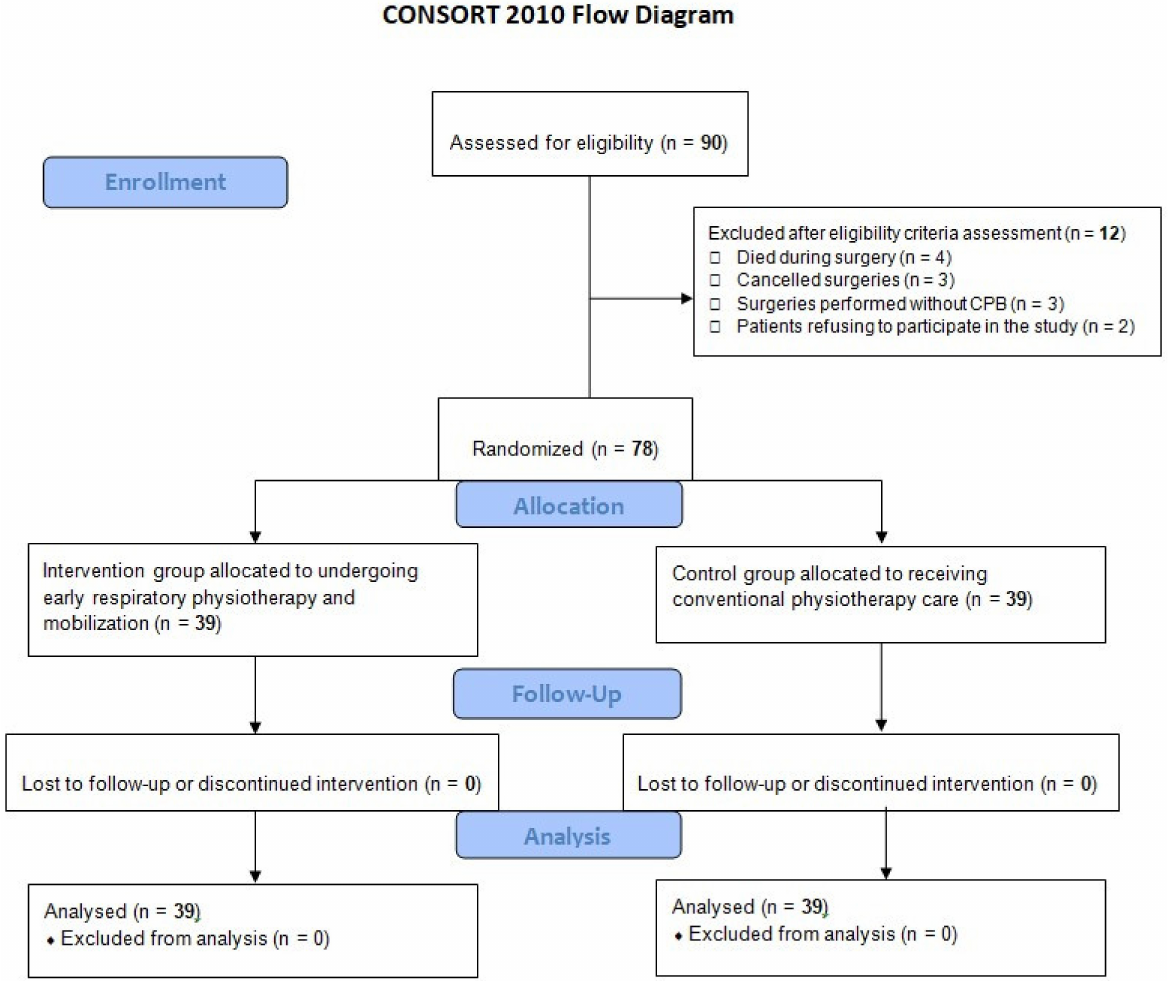
Figure 1. Flowchart of patient participation in this randomized controlled trial according to the CONSORT 2010 statement